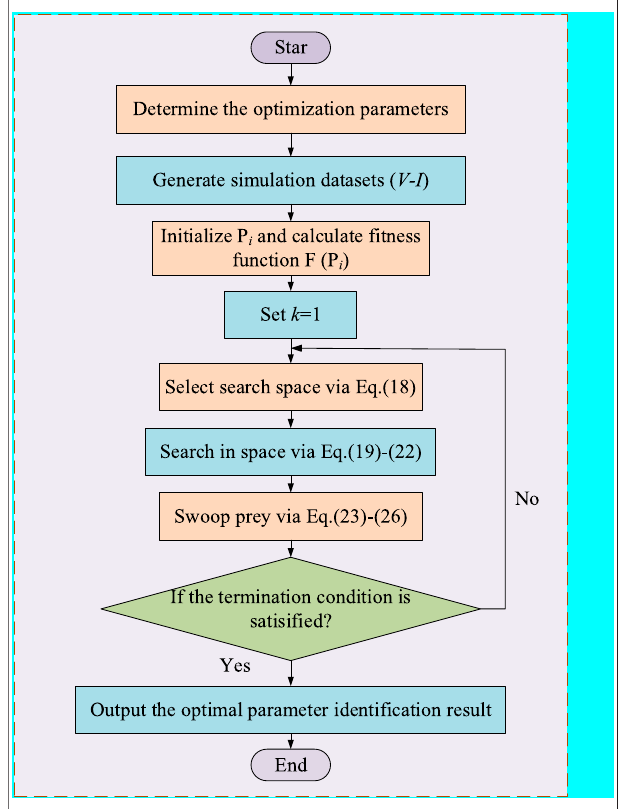
FIGURE 2 | Overall fl owchart of BES-based PEMFC parameter identi fi cation.